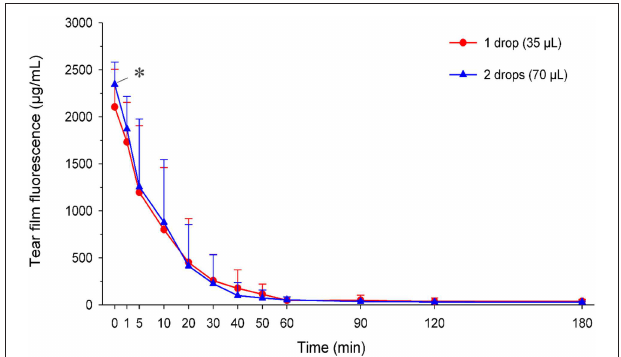
FIGURE 7 | Scatter plot depicting the mean + SD of tear film fluorescence over time in canine eyes receiving either one drop (35 µ l; red circles) or two drops (70 µ l; blue triangles) of 1% fluorescein solution. Differences in tear fluorescence were noted at t = 0min ( P = 0.046) but no other time points ( P ≥ 0.163).